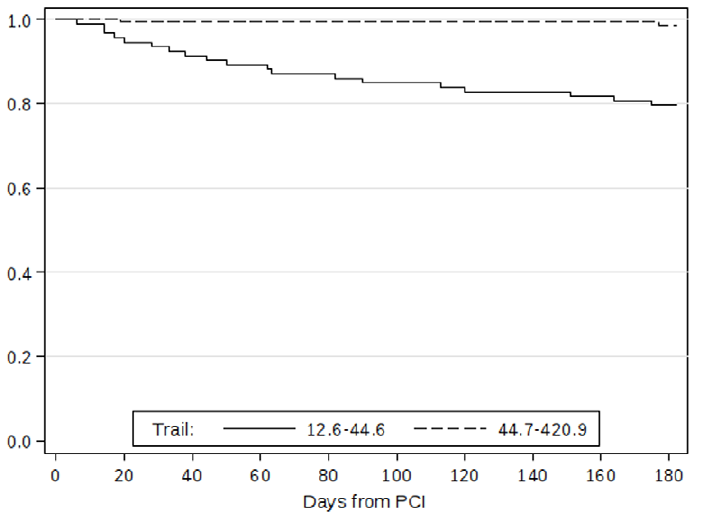
Figure 3. Kaplan – Meier survival curves event rate in patients grouped according to calculated optimal cut-off value of TRAIL. Patients with TRAIL concentrations up to 44.6 ng/mL are shown as a solid curve, patients with TRAIL concentrations higher than 44.6 ng/mL are shown as a dotted curve. P , 0.001 (log rank test).